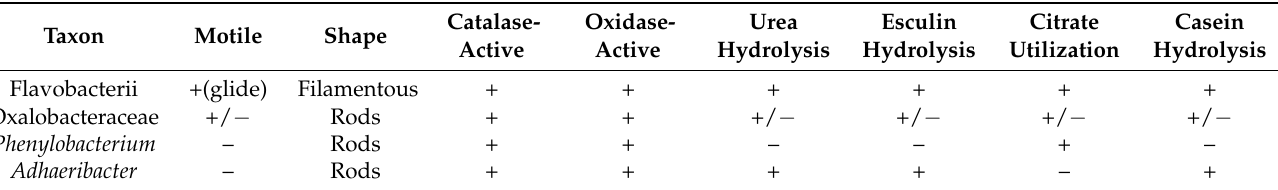
Table 2. Selected Gram-negative bacterial taxa strongly affected by HAp.